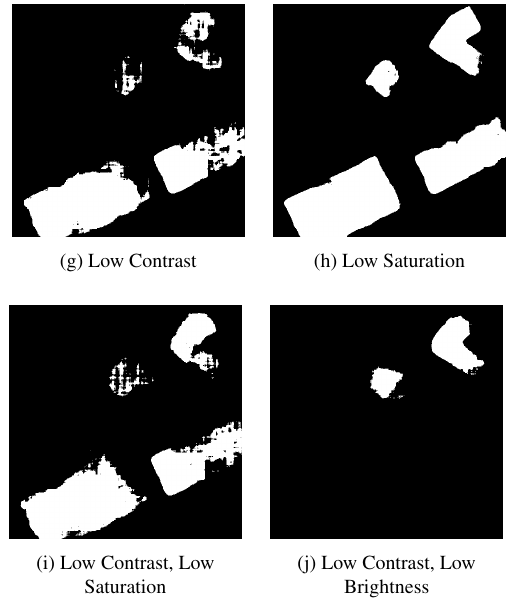
Figure 4. Exemplary depiction of segmentation maps when using altered images alongside ground truth and